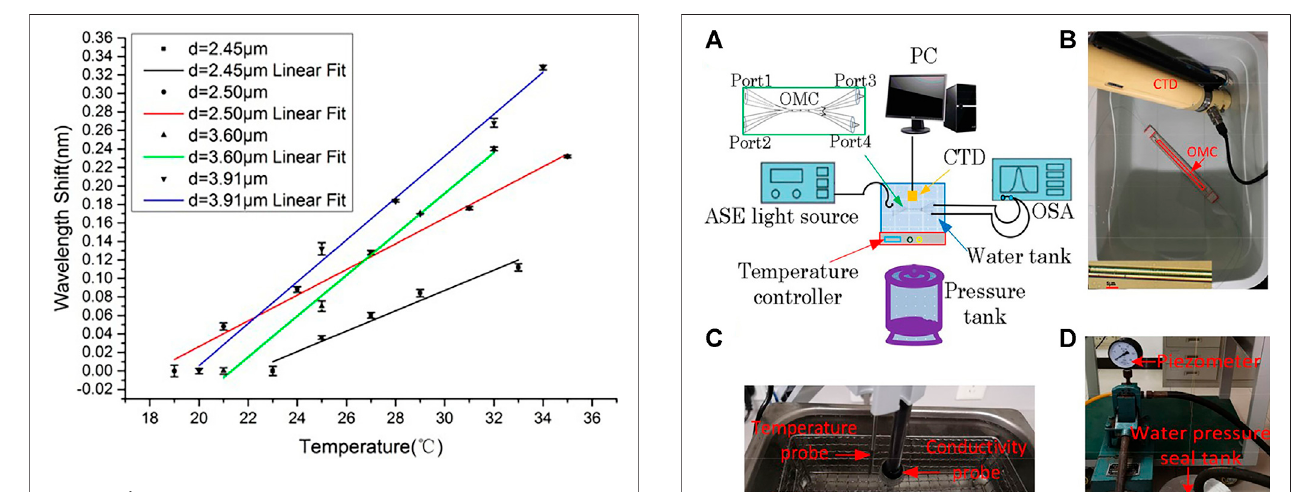
FIGURE 9 | The linear fi ttings of resonant wavelength with temperature for MKRs with fi ber diameters of 2.45-, 2.50-, 3.60- and 3.91- μ m. The error bars show the differences between experimental and fi tting results.